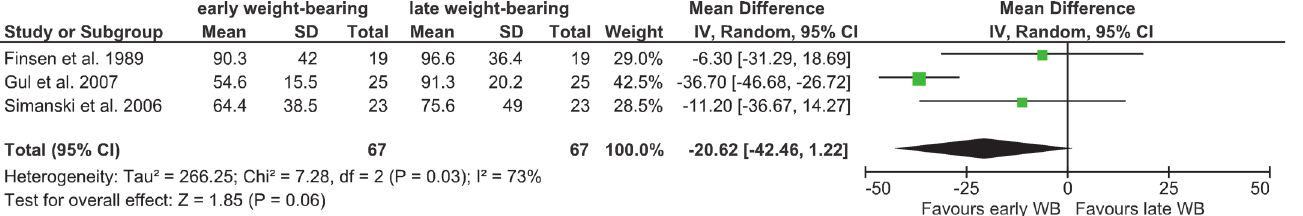
Fig 4. Effect of weight-bearing; return to work/daily activities. The mean difference (SD) on the return to work/daily activites is shown between the early weight-bearing groups and the late weight-bearing groups.